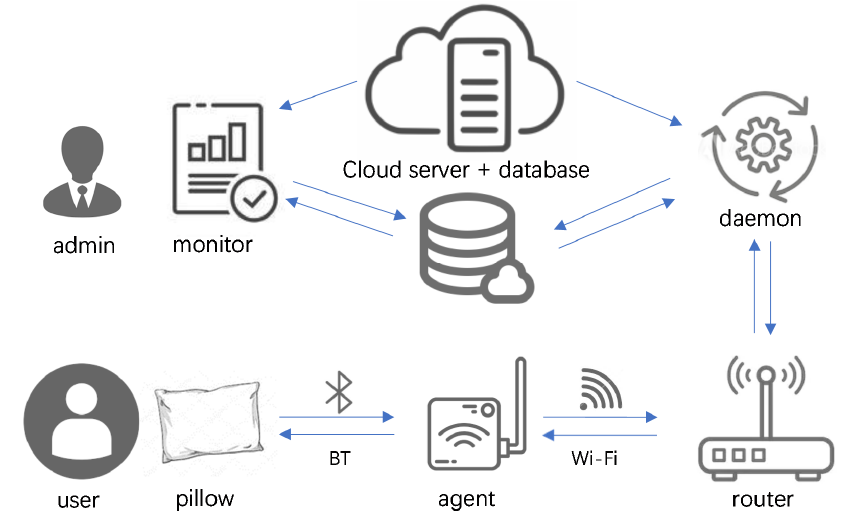
Figure 8. The connection of all parties in the Remote Healthcare System.